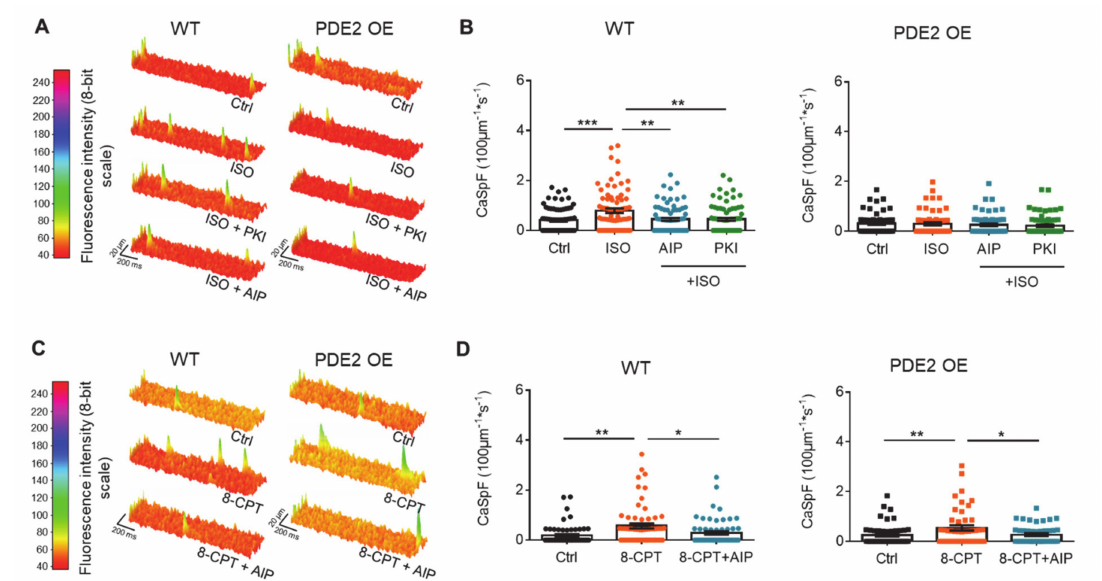
Figure 3. β -AR stimulation does not increase Calciumspark frequency upon β -adrenergic stimulation in PDE2 OE. Ventricular myocytes were loaded with fluo-4 AM and monitored for spontaneous intracellular rises in Ca 2+ levels (Ca 2+ sparks) by line scan confocal microscopy ( A , B ) under basal conditions (black) and after 10 min stimulation with ISO (100 nM, orange), ISO (100 nM) and AIP (1 µ mol/L, blue), ISO (100 nM) and PKI (5 µ mol/L, green); ( C , D ) 8-CPT (10 µ mol/L, orange), 8-CPT (10 µ mol/L) and AIP (1 µ mol/L, blue). ( A , C ) Representative original registrations and ( B , D ) quantification of Ca 2+ spark frequency (CaSpF) normalized to cell width and scan rate from WT (circles) and PDE2 OE (squares). * p < 0.05, ** p < 0.01 *** p < 0.001. (N = 4 animals/genotype, 45 ≤ n ≤ 79